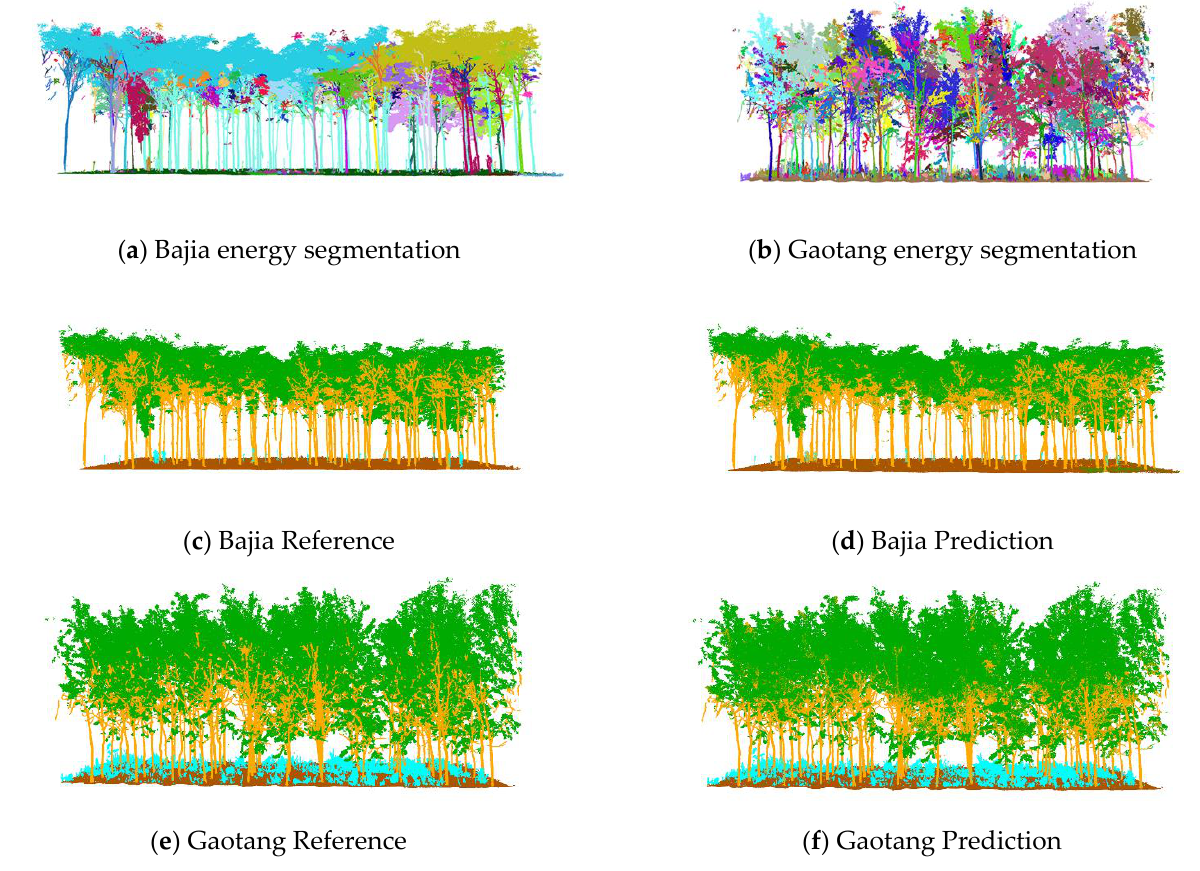
Figure 9. ( a – f ) Results of the energy and semantic segmentation of two different datasets, in the semantic segmentation results. The left graph shows the manually calibrated reference and the right shows the predicted results.